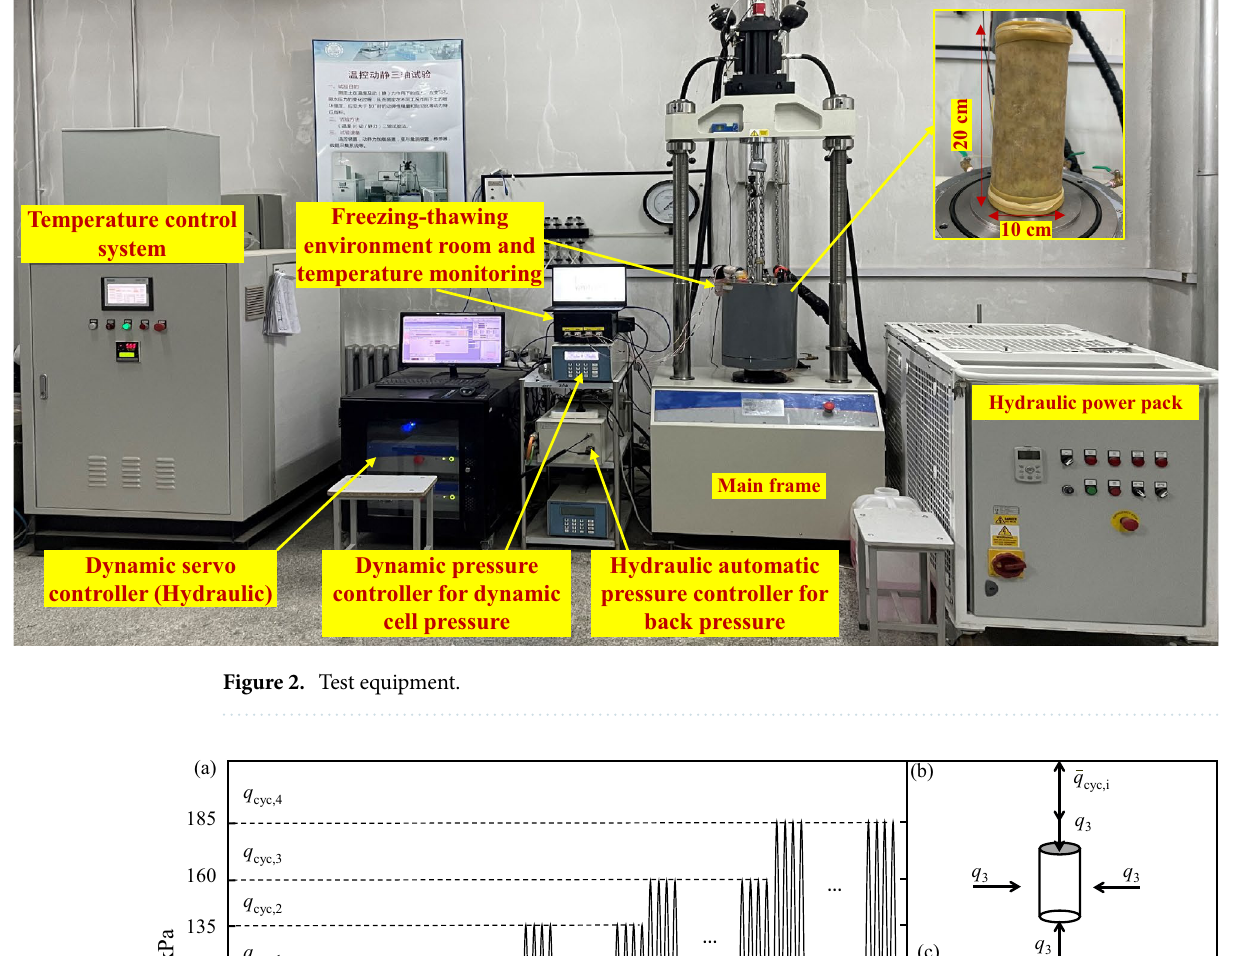
Figure 2. Test equipment.